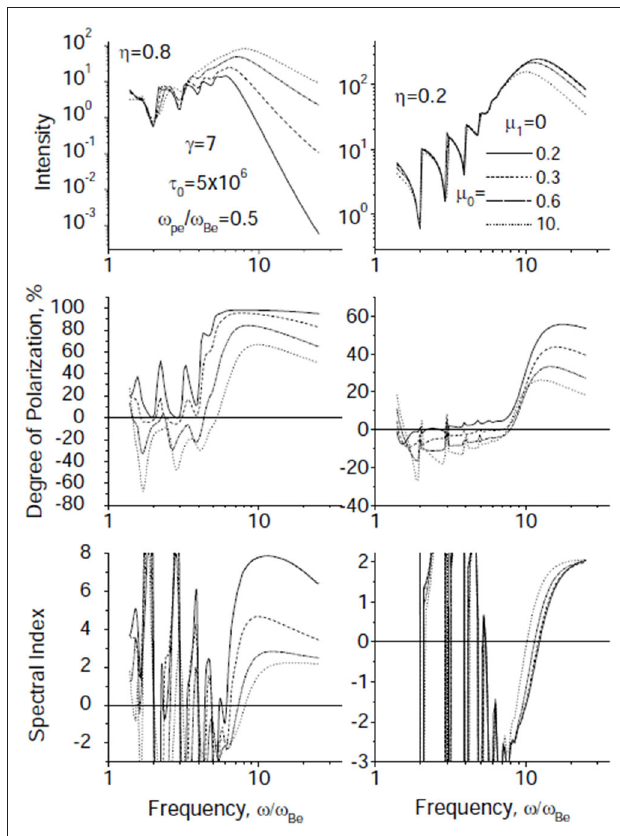
FIGURE 12 | Gyrosynchrotron intensity, degree of polarization and spectral index as a function of frequency for various values of µ 0 in the Gaussian loss-cone type pitch-angle distribution f presented in the left and right columns have been made for η respectively, where η is the cosine of the angle between the magnetic field and the line of sight (from Fleishman and Melnikov, 2003a). © AAS. Reproduced with permission.